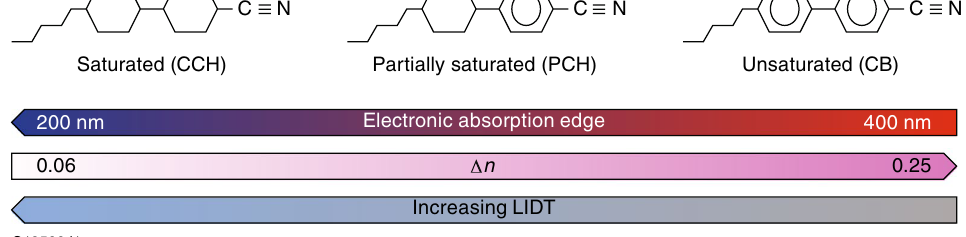
Figure 1. Molecular structures for the three classes of LC compounds in Table 1 and a graphical representation of dependence of optical absorbance, birefringence, and laser damage with respect to these